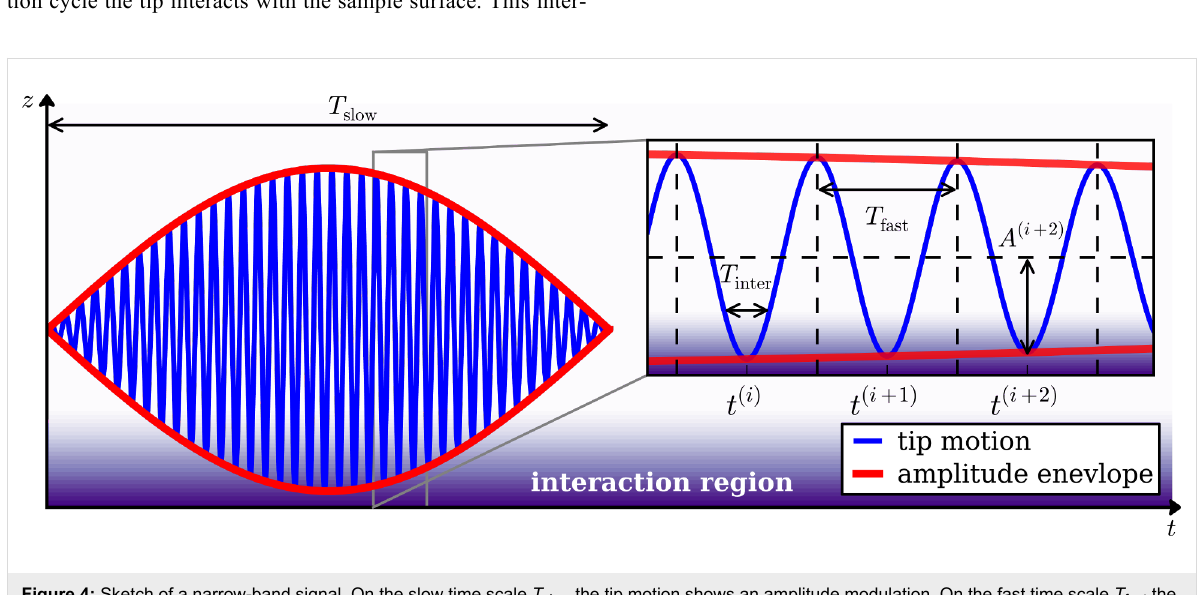
Figure 4: Sketch of a narrow-band signal. On the slow time scale T slow the tip motion shows an amplitude modulation. On the fast time scale T fast the signal rapidly oscillates. During each oscillation cycle the tip interacts with the surface for the time T inter during which the oscillation amplitude and phase are approximately